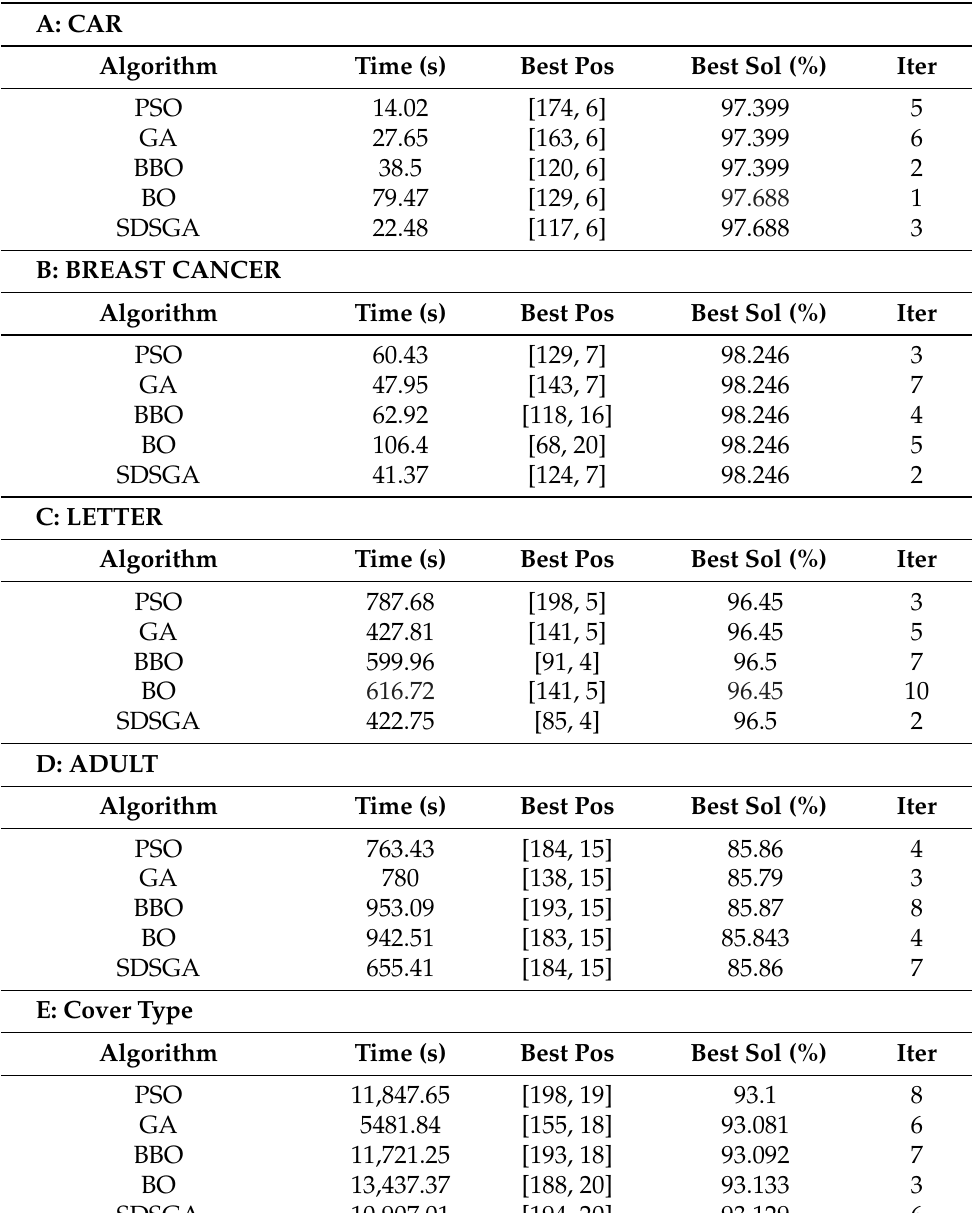
Table 4. Performance of the metaheuristic-based algorithms on RF trained on four different UCI